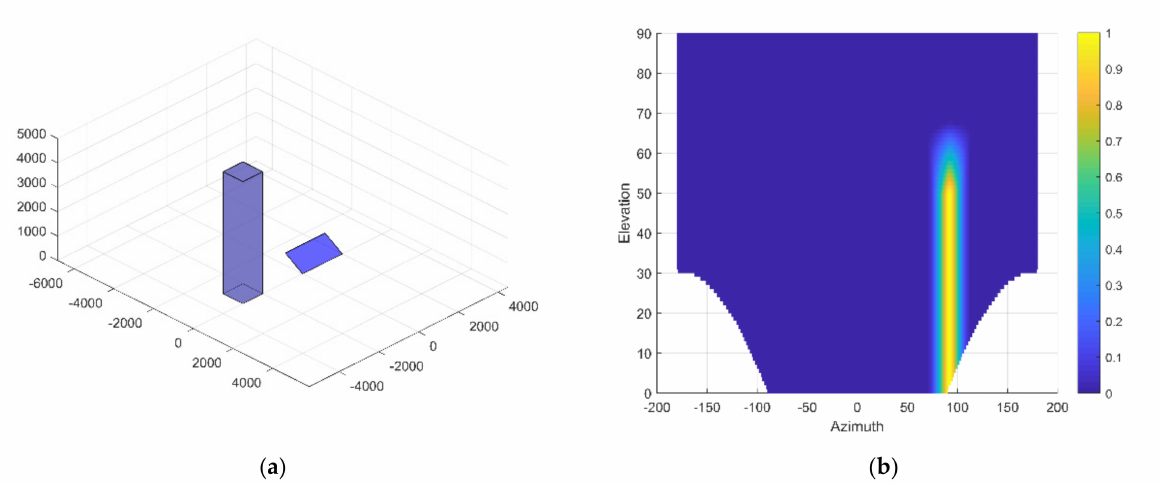
Figure 13. Situation 1, one PV module being shaded by one obstacle positioned on its east side with 2 m of separation. The tilt angle of the module is 30 ◦ and the azimuth angle is 0 ◦ : ( a ) Visual output; ( b ) Heat plot representation of the shading